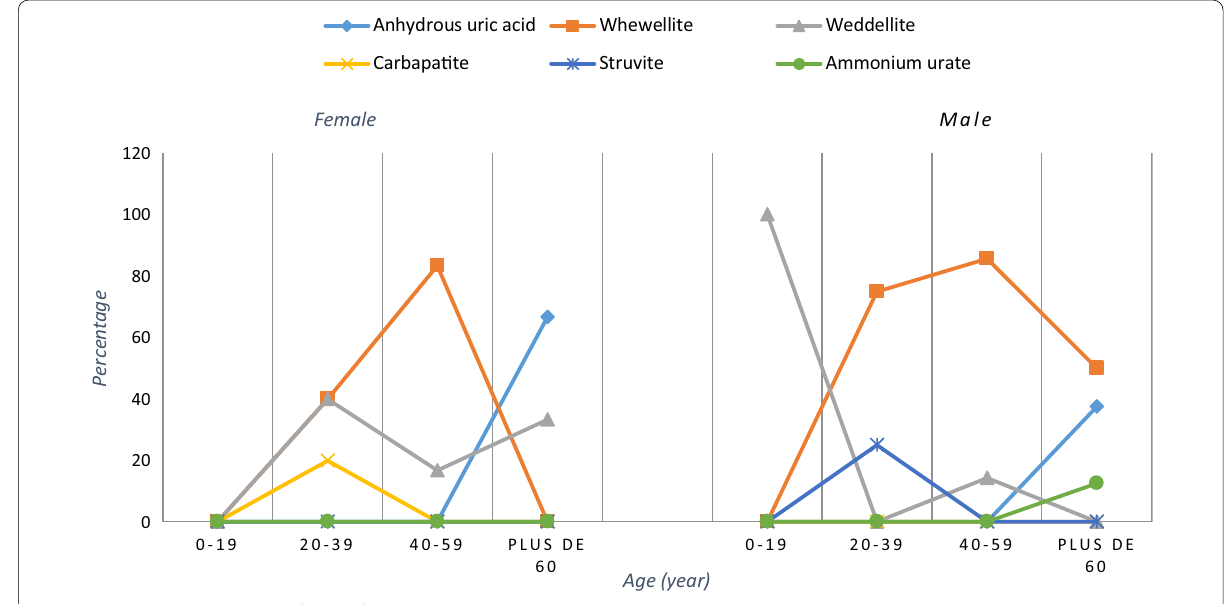
Fig. 2 Stones main components by gender